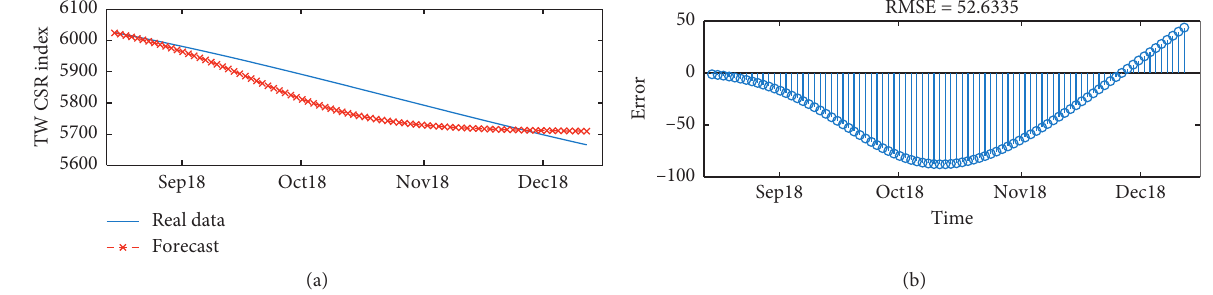
Figure 22: LSTM prediction and actual verification results for IMF6 with RMSE of